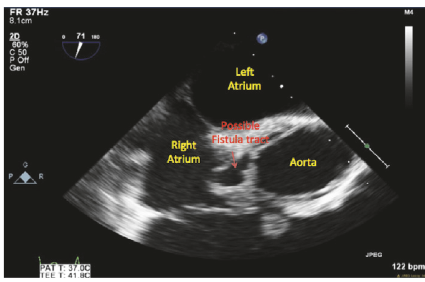
Figure 2: Aortic root mass with central clearing, indicating an abscess.